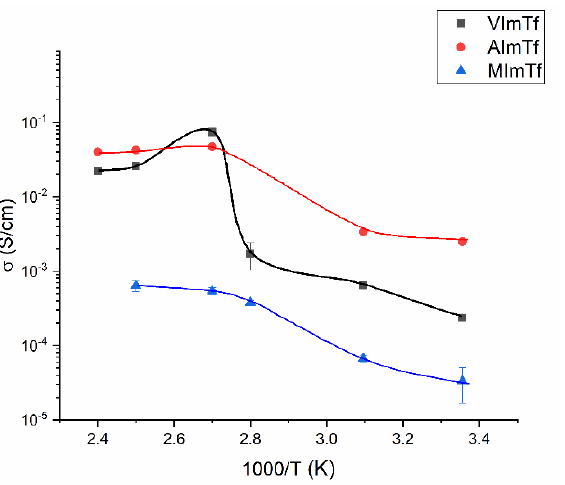
Figure 2. Ionic conductivity of synthesized PILs as a function of the reciprocal temperature.